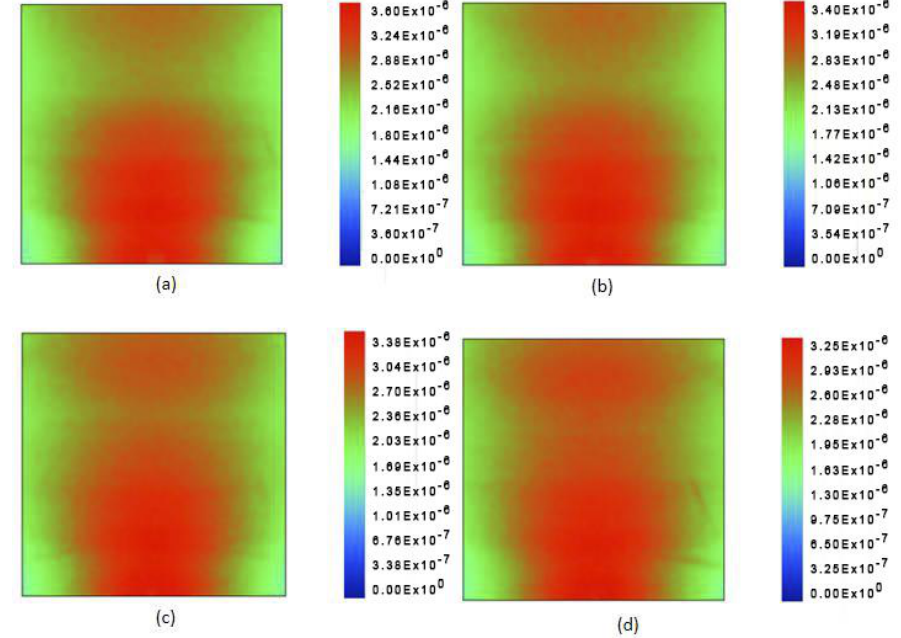
Figure 5. Light distribution of lens B4 on the floor at distance from the ceiling of ( a ) 20 cm; ( b ) 30 cm; ( c ) 40 cm; ( d ) 50 cm.